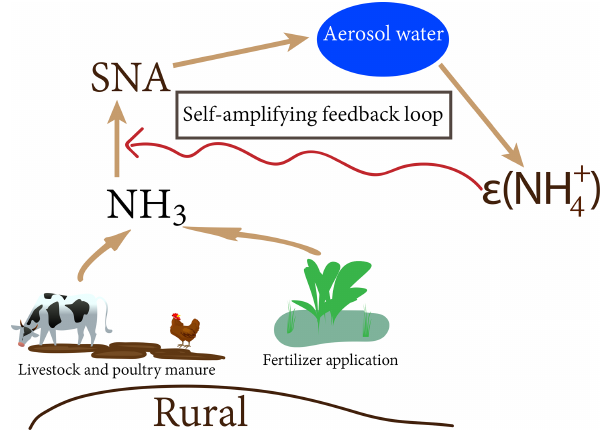
Figure 9. Schematic of self-amplifying feedback loop for SNA for- mation.